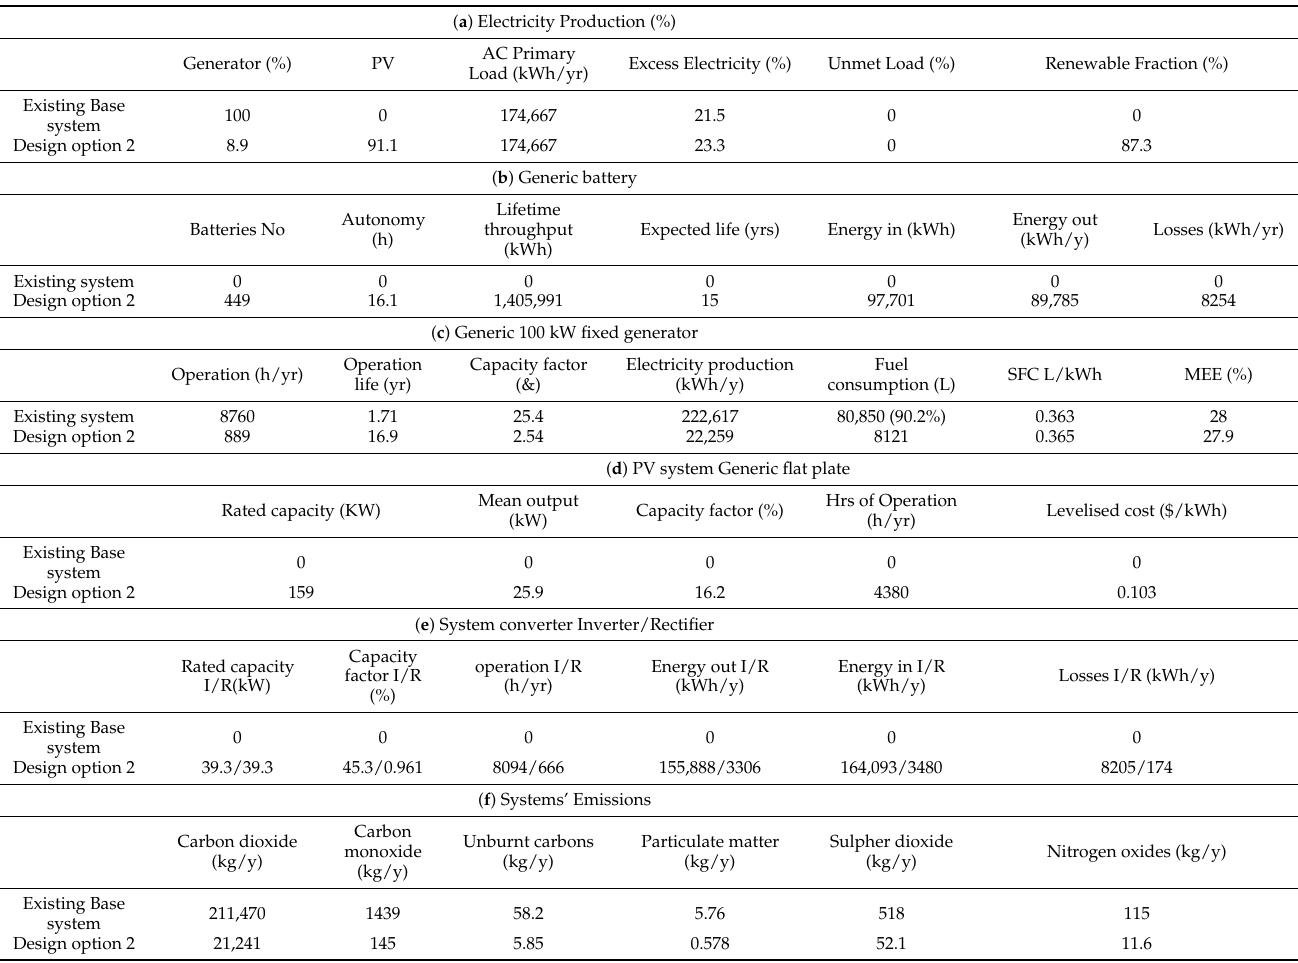
Table 7. ( a – f ): Design option 2 comparing technical parameters of the base system and proposed hybrid system of simulated values.